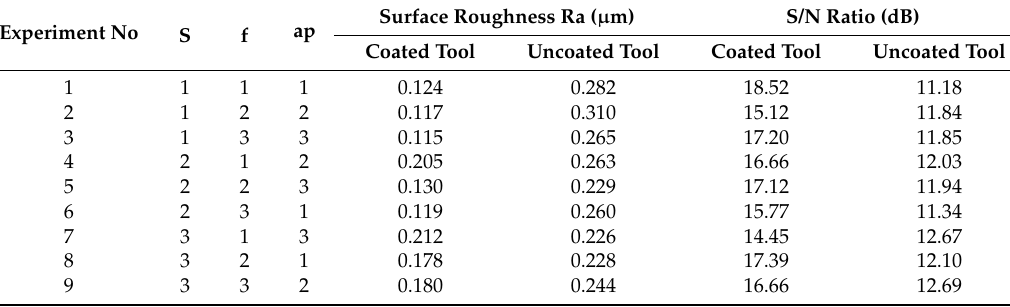
Table 6. The experimental results for surface roughness and S/N